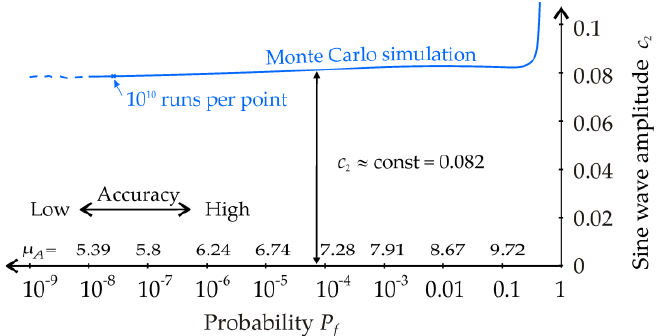
Figure 11. Parameter of pseudorandom model uncertainty — case study 5.